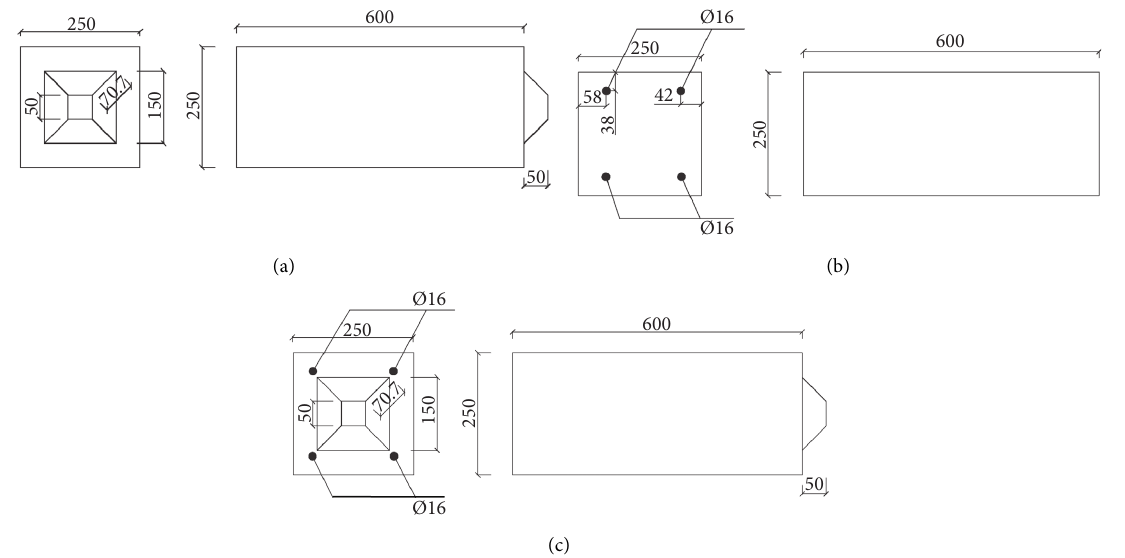
Figure 5: Dimension of the panels. (a) Dimension of Type 1. (b) Dimension of Type 2. (c) Dimension of Type 3.